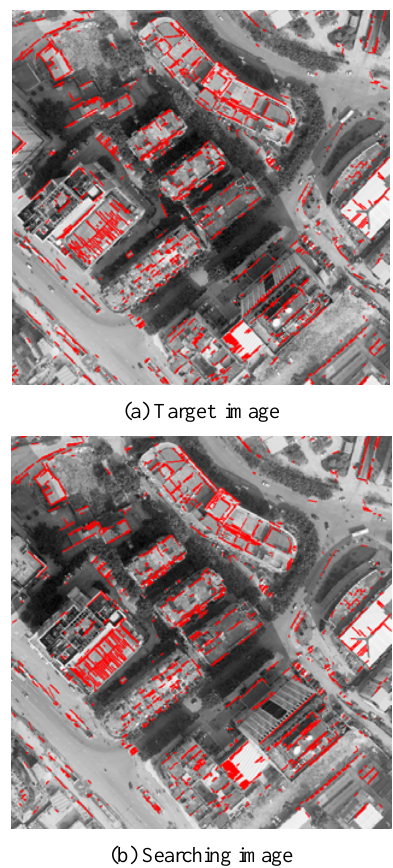
Figure 8. The line matching results under the multi-constraint